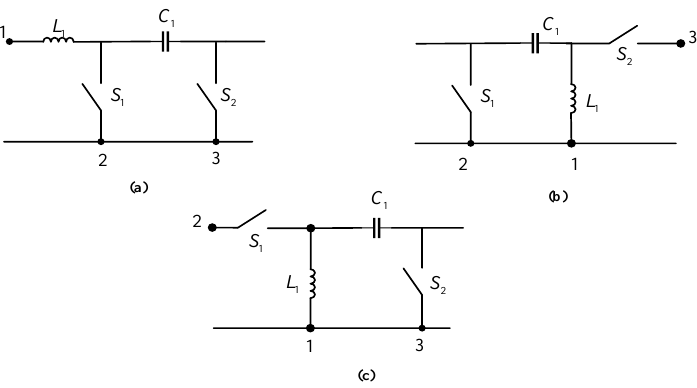
Figure 7. Rail connection variants for the lumped Type 2 BBBs. ( a ) Switch and diode to rail, ( b ) Inductor and switch to rail, and ( c ) inductor and diode to rail .